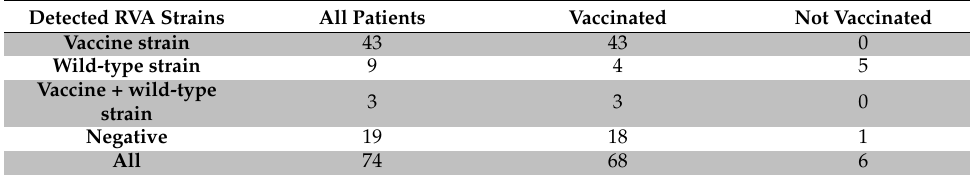
Table 3. Frequency of RVA vaccine and wild-type strains detected in the study group. Detected RVA Strains